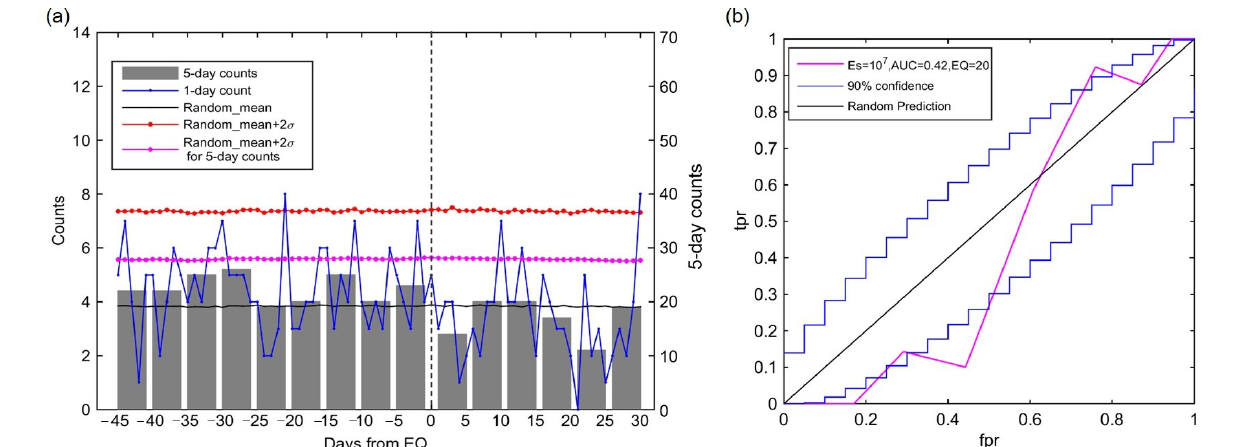
Figure 7. ( a ) The SEA results of strain network anomalies for shuffled earthquakes with E s ≥ 10 7 . The blue, the black, and the red lines indicate the counts of 1-day count, random_mean, and random_mean+ σ , respectively. The grey bars and the pink line demonstrate 5-day counts and corresponding random_mean+ σ . ( b ) The pink line shows the ROC prediction between the network degree and the shuffled earthquakes, under the condition of N ano = 7 and T alm = 1 days. The black diagonal line indicates prediction by random guessing, whereas the blue steps provide 90% confidence intervals for the random prediction. For this prediction, the AUC was 0.42.